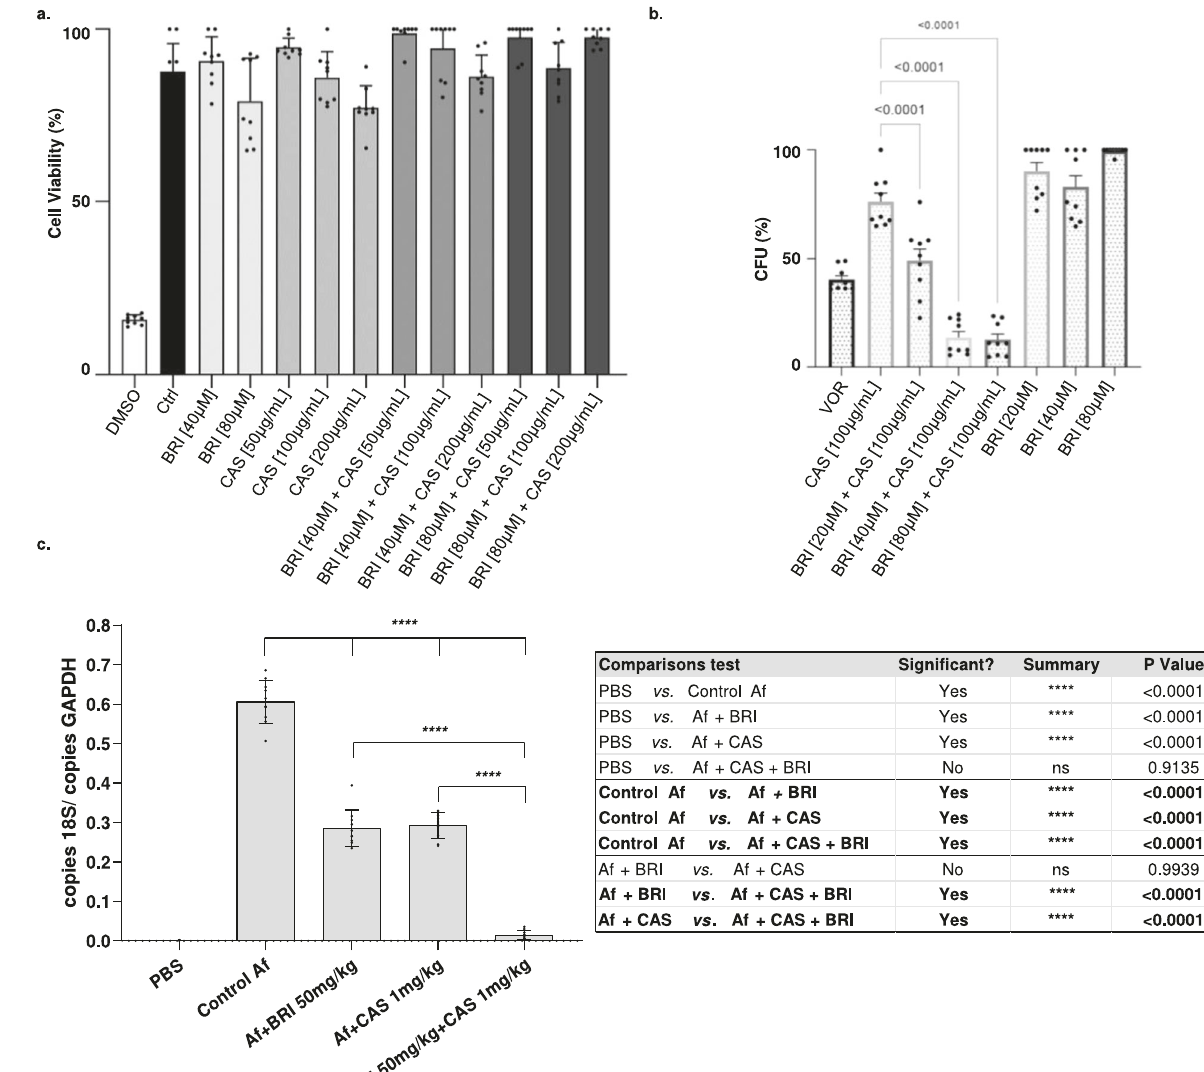
Fig. 6 | The combination of BRI+CAS is not toxic to human cells and can sig- ni fi cantly decrease the A. fumigatus fungal burden in a chemotherapeutic murine model. a A549 lung cells grown in the absence or presence of different concentrationsofBRIandCAS.DMSO10%wasusedaspositivecontrol.Percentage ofcellviabilityisexpressedastheabsorbancevalueofexperimentwell/absorbance value of control well x 100. All the results are the average of three repetitions ±SD. b A549 cells were seeded at a density of 106 cells/ml and challenged with A. fumigatus conidiaatamultiplicityofinfectionof1:10intheabsenceorpresenceof different concentrations of BRI and CAS. After 24h of incubation media was removed and the cell suspension were seeded in Sabouraud Dextrose Agar Media. The numbers of CFUs were determined after 24h of growth. The CFU percentage